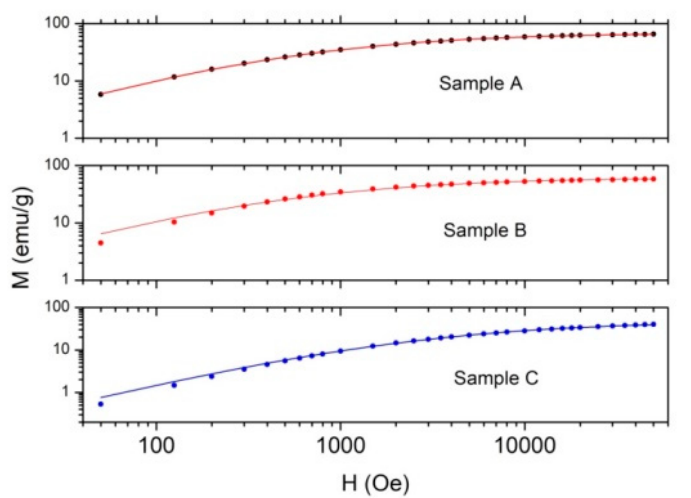
Figure 7. Fitting (solid lines) of the experimental magnetization vs. magnetic field intensity curves measured at RT for the three samples (filled circles) by using Equation (1).